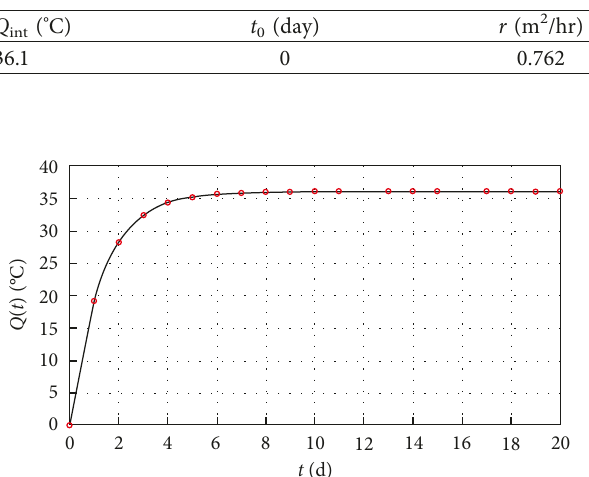
Table 2: Related parameters of adiabatic temperature rise for abutment concrete.